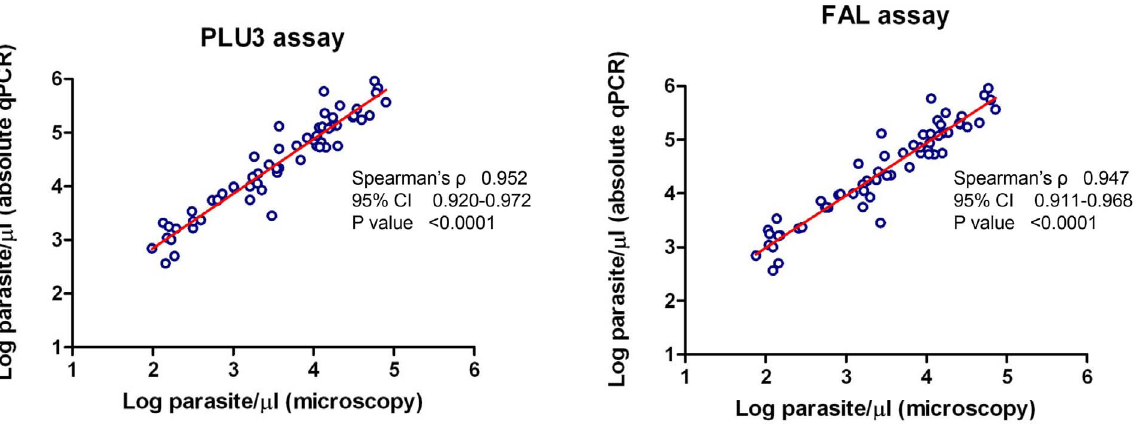
Figure 3. Analysis of parasite densities in clinical samples using absolute qPCR and microscopy. Absolute quantitative qPCR was performed using plasmid DNA as the standard to analyze clinical samples. The log 10 parasite densities in terms of parasite/ m l was determined from qPCR assays and compared to the log 10 parasite densities as determined by expert microscopist. The correlation coefficient of parasite densities measured using the two methods was calculated using the nonparametric Spearman correlation coefficient. There was a statistically significant correlation between parasite density measured by microscopy and absolute quantitative qPCR.